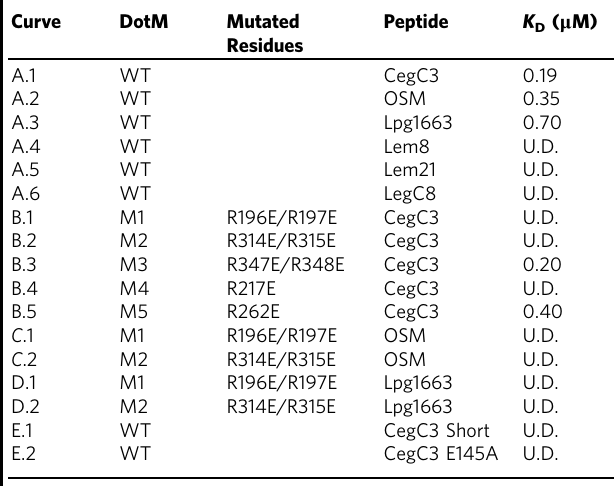
Table 3 Binding dissociation binding constants derived from isothermal titration calorimetry Curve